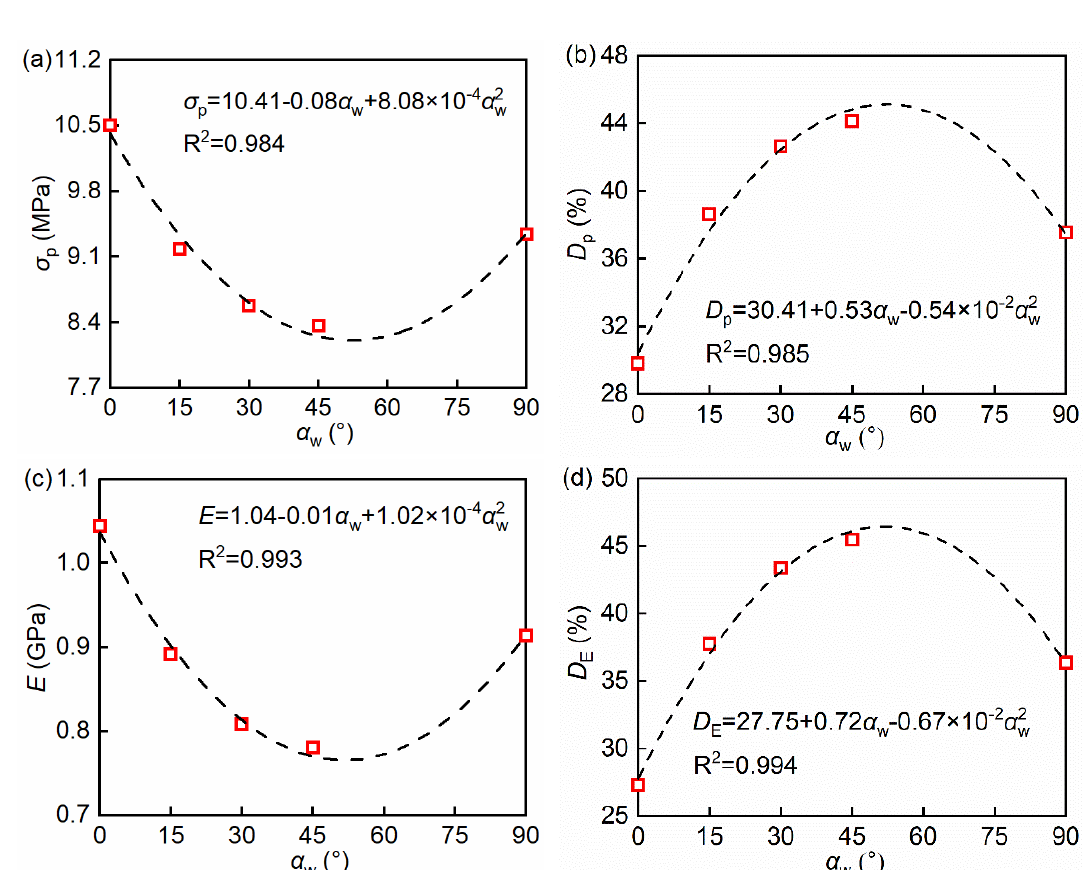
Figure 9. The σ p , E , D p , and D E for weak interlayer with different dip angles: ( a ) peak strength of the samples; ( b ) weakening effect index of weak interlayer on sample peak strength; ( c ) elastic modulus of the samples; ( d ) weakening effect index of weak interlayer on sample peak strength.